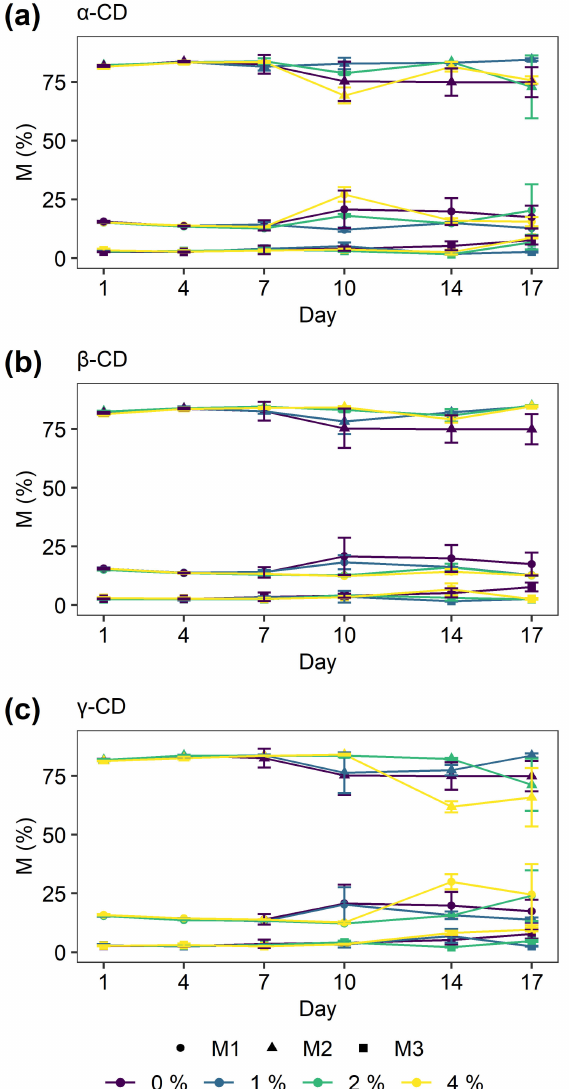
Figure 5. The relative abundances (M n ) of the three different proton populations in the breads with different types and concentrations of α -CD ( a ), β -CD ( b ) and γ -CD ( c ) for different storage time. The error bars indicate the standard